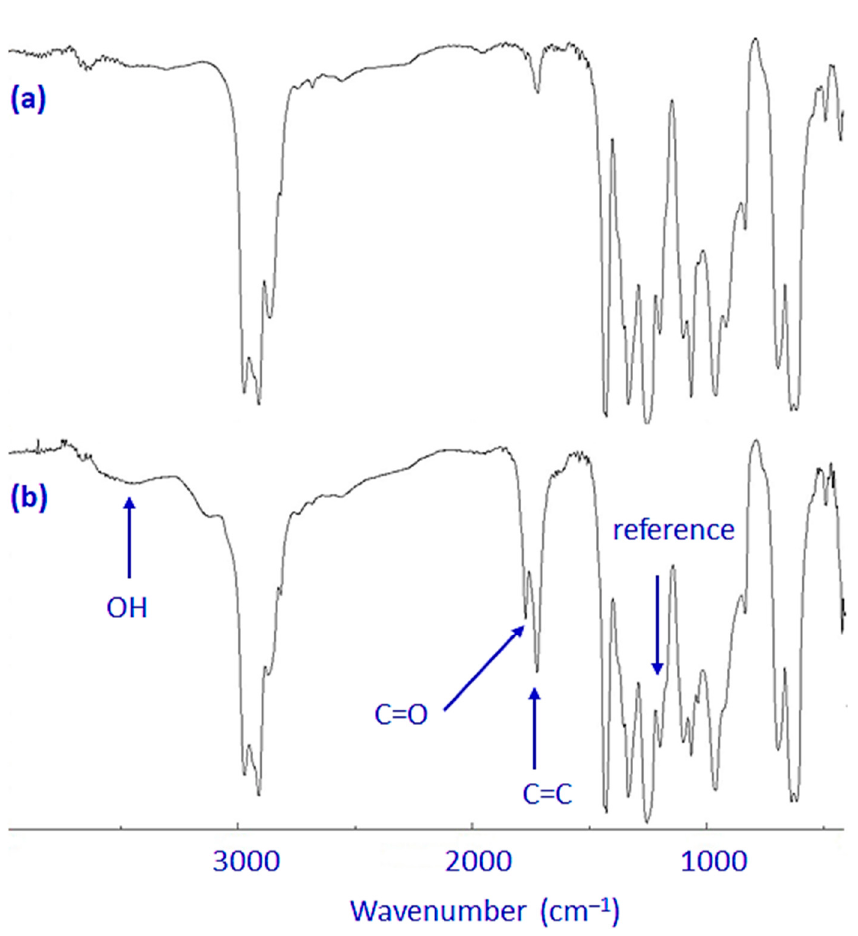
Figure 1. FTIR spectra of PVC film: ( a ) before and ( b ) after irradiation.